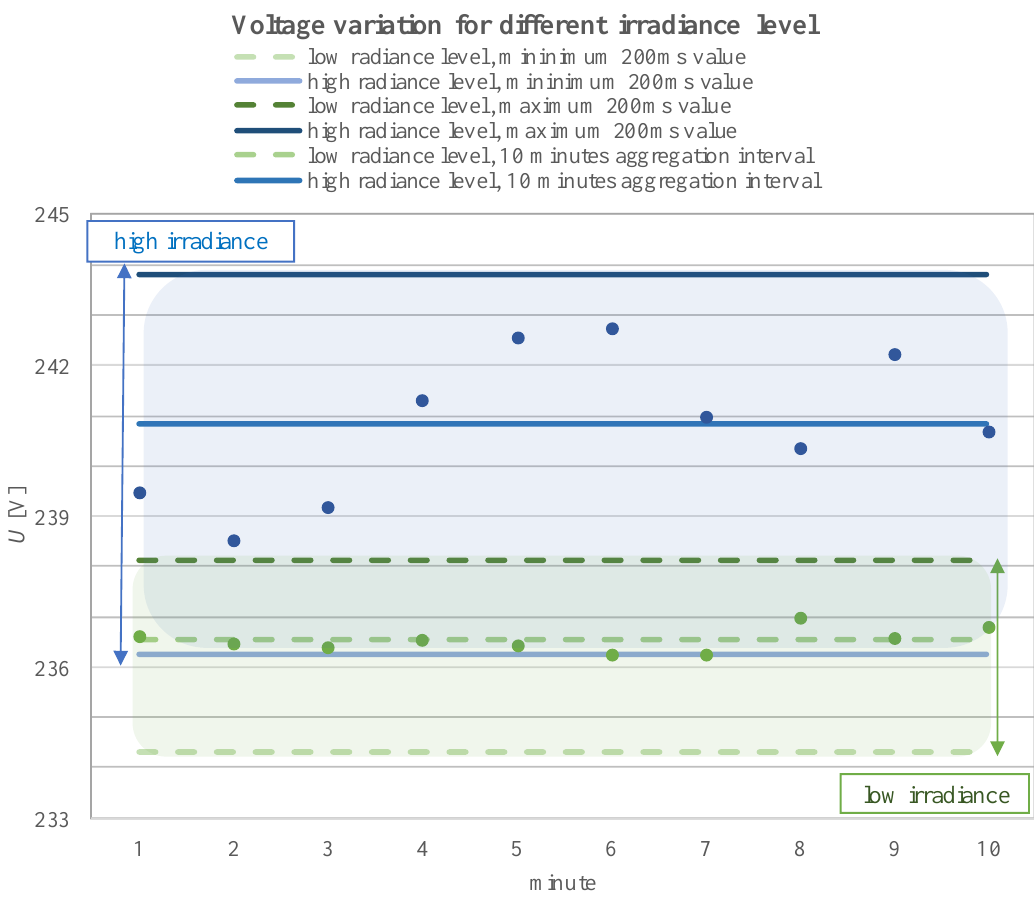
Figure 5. Observability of voltage variations of the selected phase for different aggregation intervals at different solar irradiance levels.